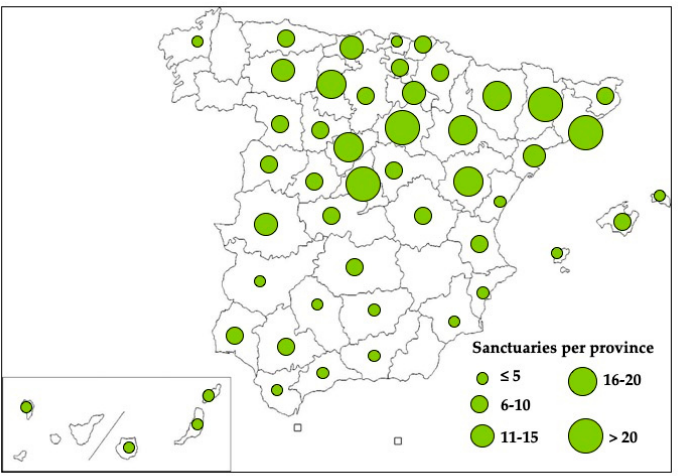
Figure 2. Geographical distribution of Marian verdant advocations in Spain.